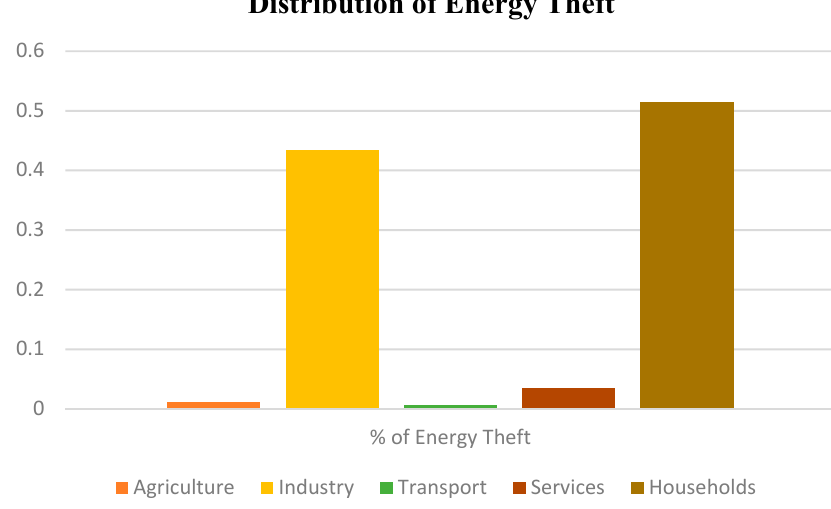
Figure 5. Distribution of Energy Consumption by Appliance.